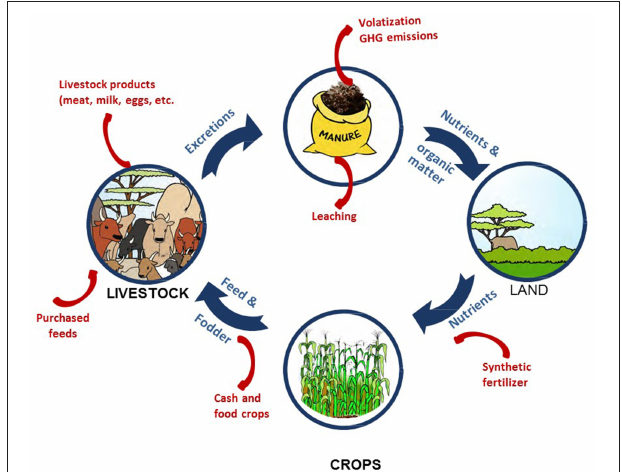
TABLE 1 | Comparison of yield improvement of various crops due to manure application in different countries in SSA. Country